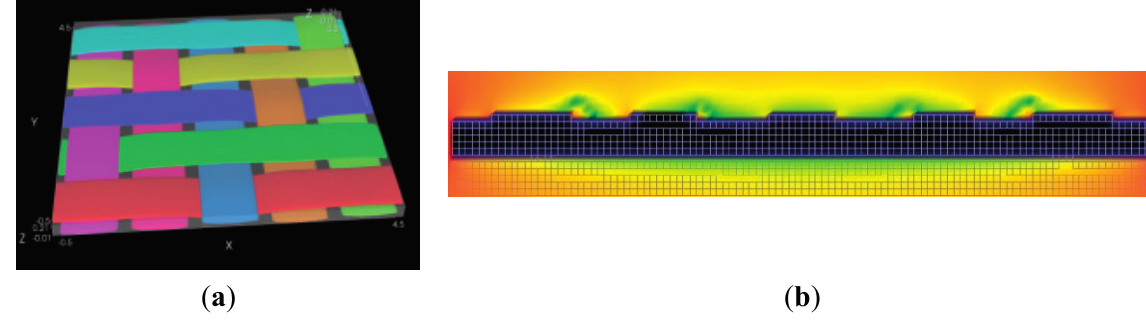
Figure 7. Simulation of one woven carbon cell: ( a ) TexGen—different colors show the intersections in the woven 5HS; ( b ) XFDTD— H y propagation in a plane orthogonal at composite.